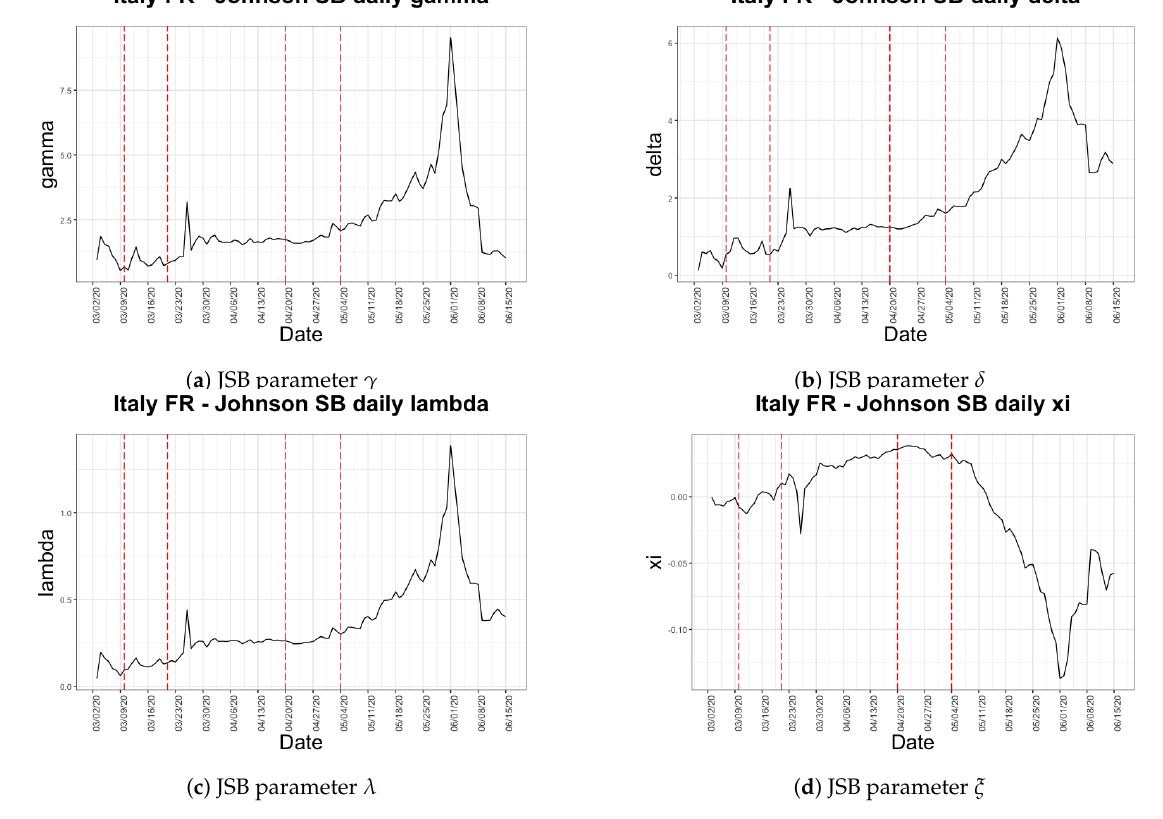
Figure 13. Time series for Italy fatality ratio Johnson S B